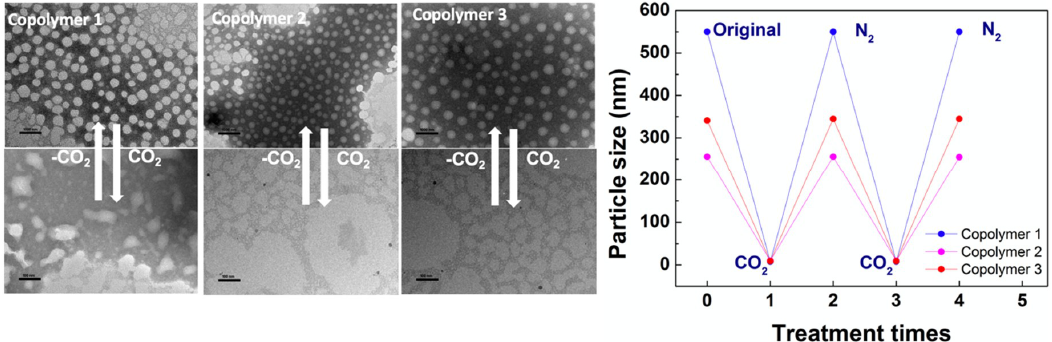
Figure 5. The TEM images (left) and change of hydrodynamic size (right) of the copolymers 1, 2 and 3 (0.2 wt%) in the presence or absence of CO 2 . The scale bars of TEM images in the absence CO 2 (upper) are 1000 nm and those in the presence of CO 2 (lower) are 100 nm.